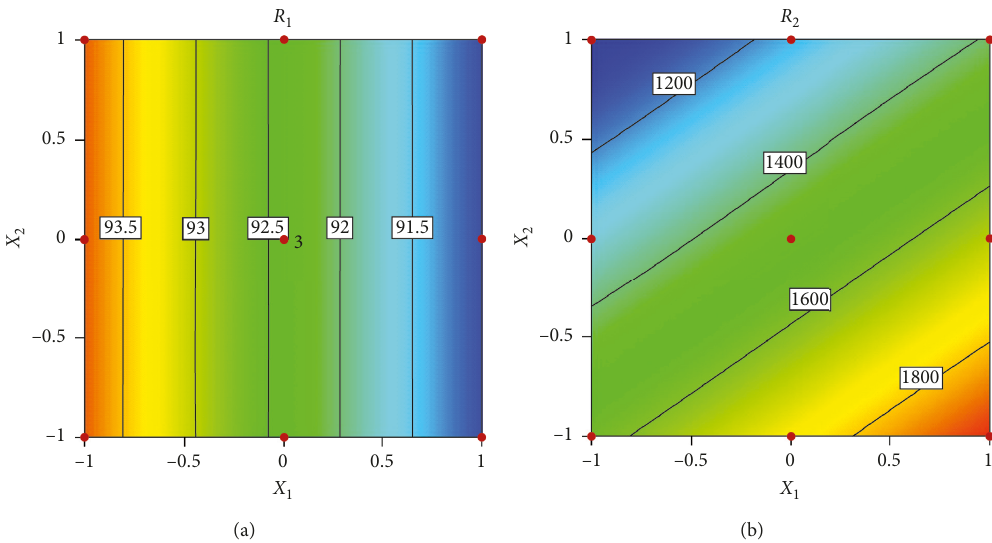
Figure 6: Contour plot showing the effect of independent variables X corresponding with simplified